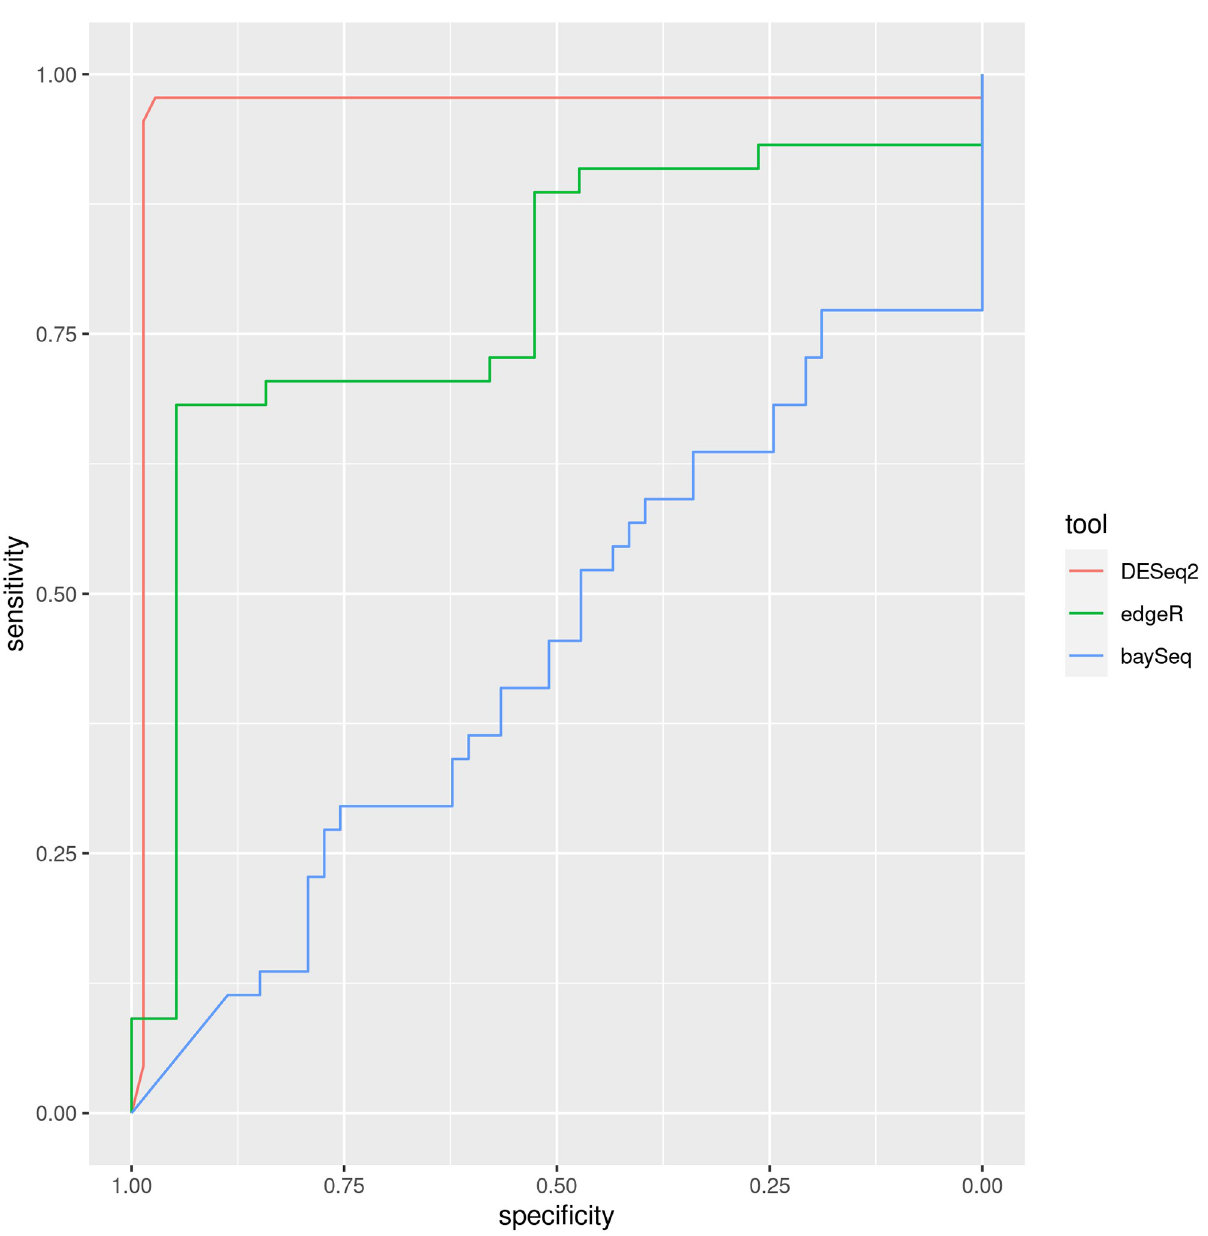
Fig 8. Effect of the differential expression package on the simulated dataset. The areas under the curves (AUC) of srnadiff, when using DESeq2, edgeR, or baySeq, is respectively 0.9639, 0.7835 and 0.4468. The (unfiltered) number of candidates for each tool is 72, 19, and 53.